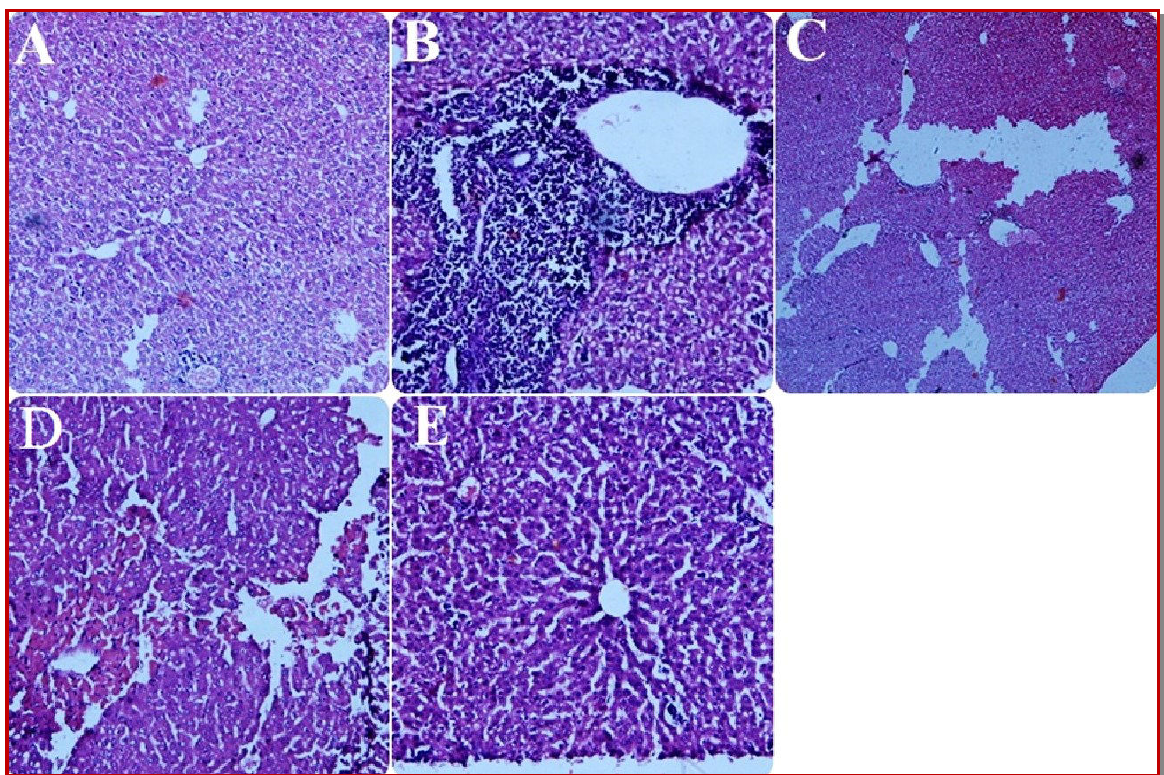
Figure 1: (A) Normal hepatocytes; (B) PCM treated; (C) Silymarin treated; (D) C. murale 250 mg/kg treated; (E) C. murale 500 mg/ kg